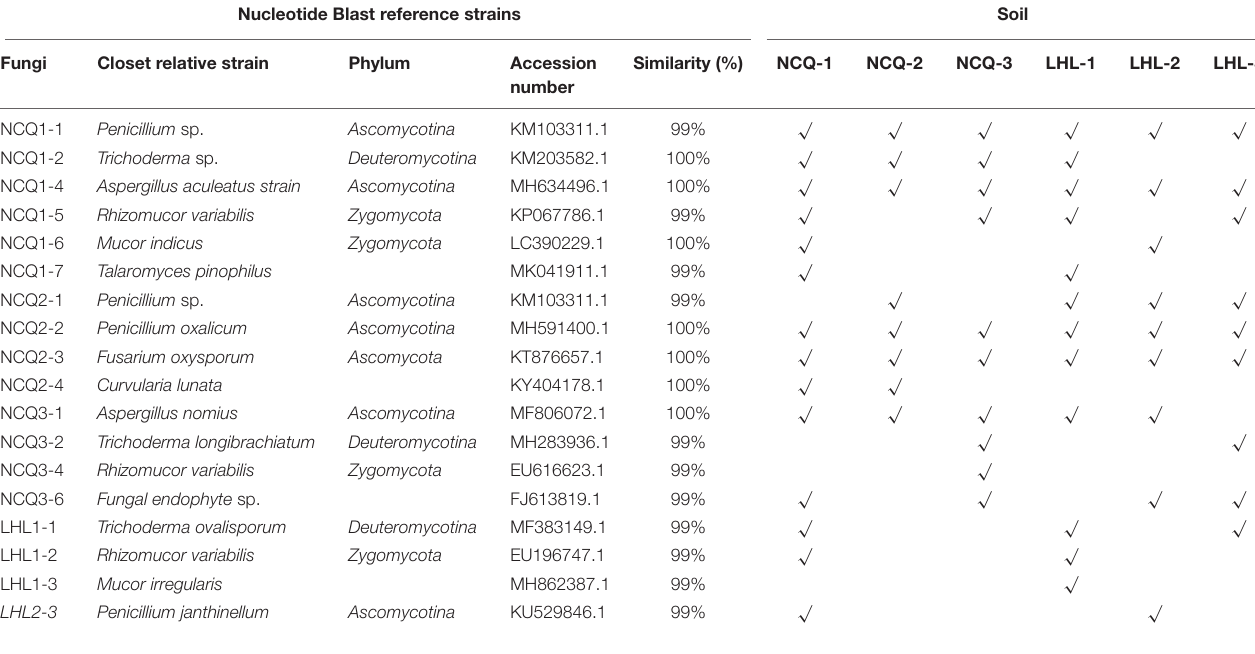
TABLE 3 | Molecular identification of strains isolated from the soil samples. Nucleotide Blast reference